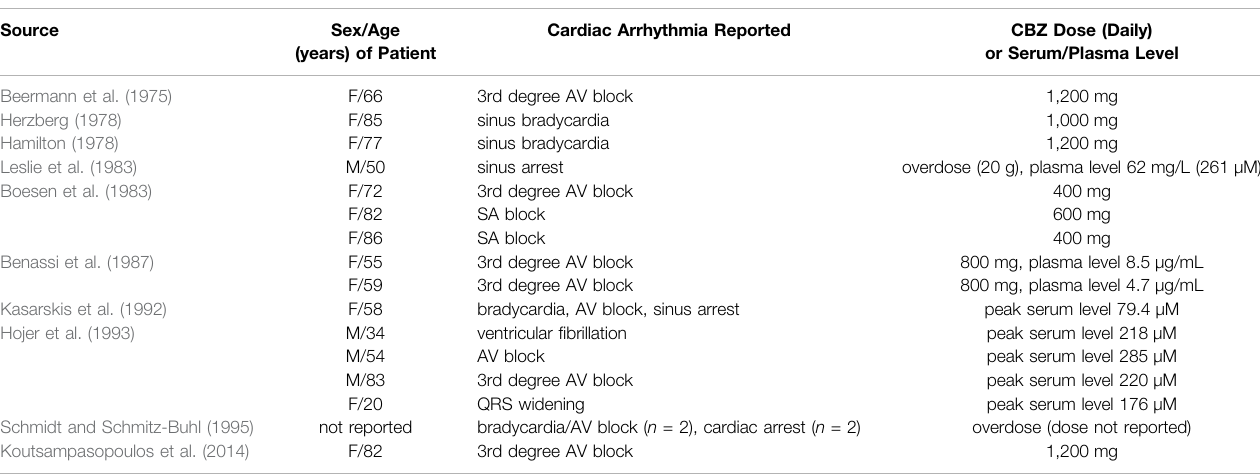
TABLE 1 | Cardiac arrhythmias observed in patients using CBZ.